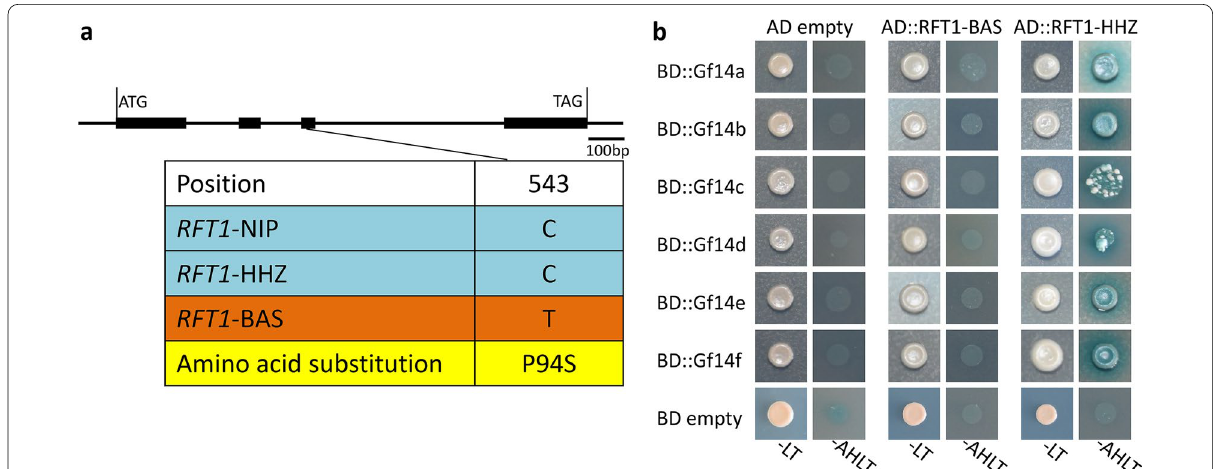
Fig. 6 a The nucleotide sequences and amino acid sequence variation sites of RFT1 in HHZ and BAS compared with Nipponbare. b The protein interactions were tested by yeast two-hybrid assays. RFT1-HHZ interacted with six members of the 14-3-3 protein family, but RFT1-BAS did not interact with any. The interactions are indicated by blue-colored yeast colonies on SD/ (-AHLT) media. SD/-Leu/-Trp